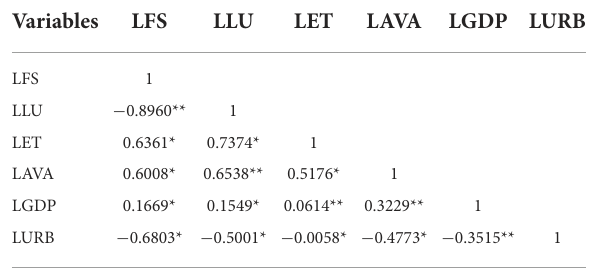
TABLE 3 Pairwise correlation test.